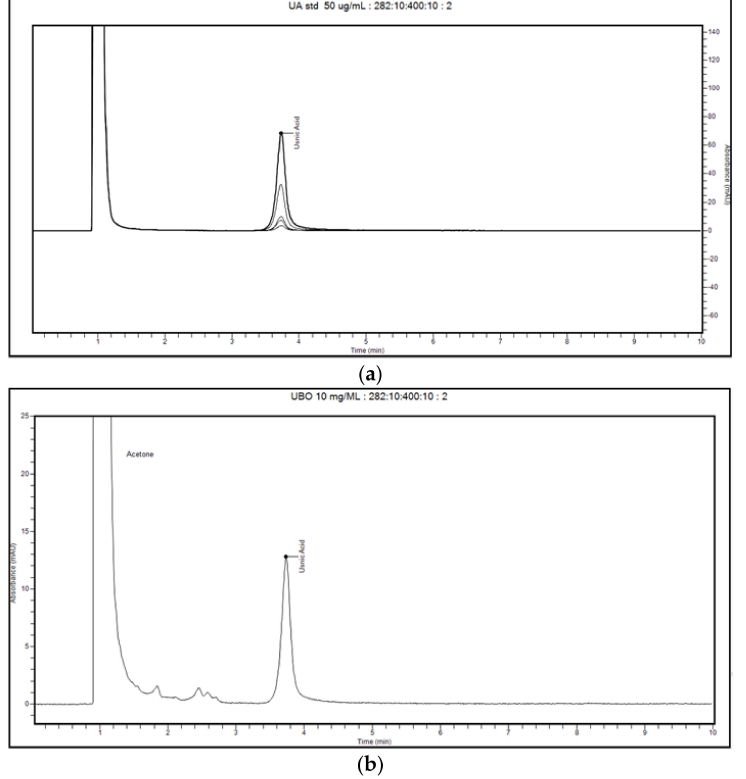
Figure 2. Chromatograms of usnic acid (UA) standards, an overlay of five peaks in a 2.5–50 µ g/mL